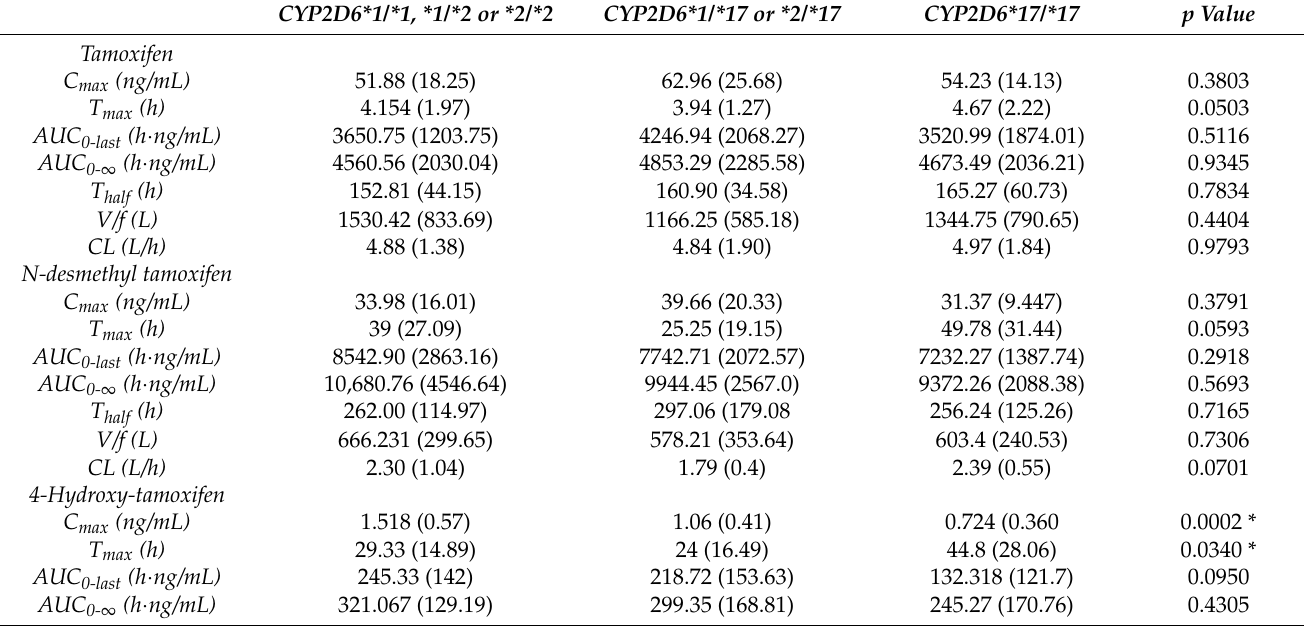
Table 2. Effect of CYP2D6 genotypes on the Pharmacokinetics of TAM and its main metabolites following a single oral dose administration of 20 mg